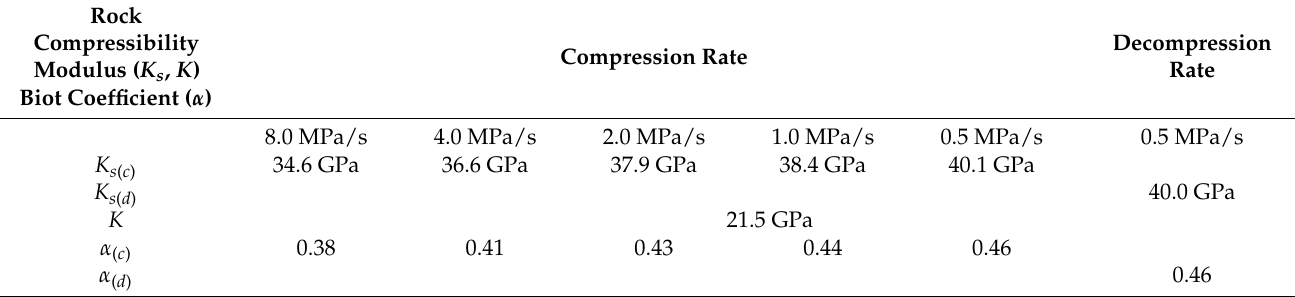
Table 4. Volumetric moduli of compressibility and Biot’s coefficients for compression ( K s ( c ) , α ( c ) ) and decompression ( K s ( d ) , α ( d ) ); SU test, Tumlin sandstone.